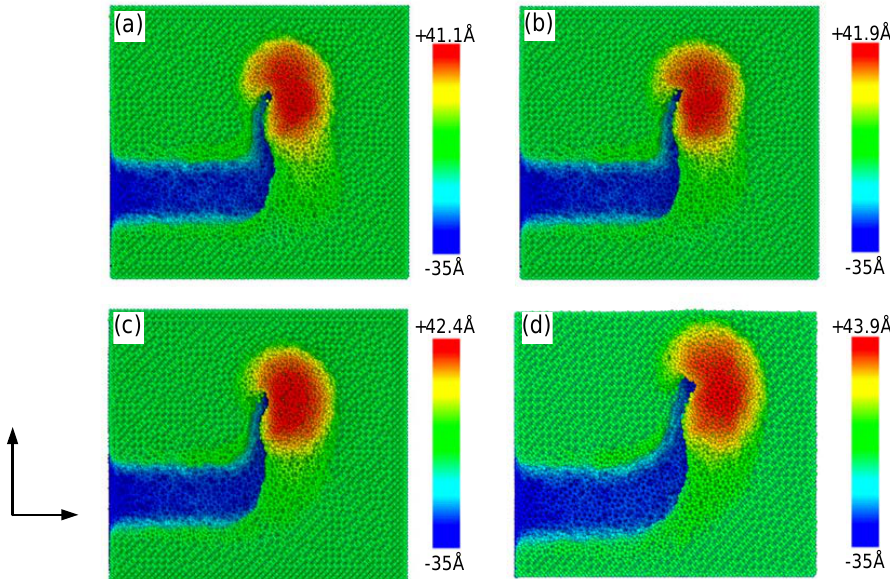
Figure 3. Surface morphology after grinding with different arc radii: ( a ) 0 Å;( b ) 20 Å; ( c ) 40 Å; and ( d ) 60 Å. The color of the atoms represents their coordinates on the Z-axis.